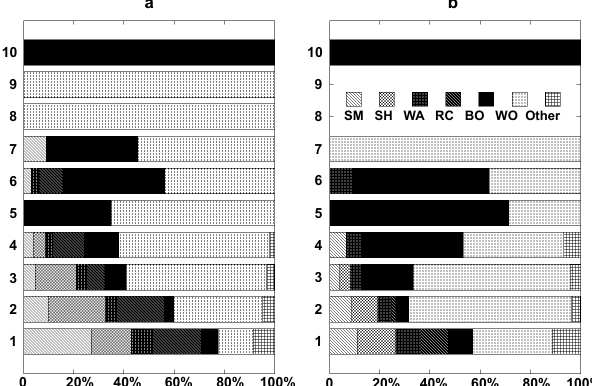
Figure 6. The relative abundance according to the 2005 forest in- ventory (a) and the total relative mortality of each species from 2005 to 2014 (b) in each diameter at breast height (DBH at 1.3m) class. The relative abundance is expressed as a percentage of stem num- ber of each species relative to the total stand stem number in each DBH class. Similarly, the relative mortality is expressed as a per- centage of total mortality of each species relative to the total stand mortality in each DBH class. Ten DBH classes with an equal width of 6.3cm are shown. The class with the smallest DBH (class 1) starts with a DBH of 9cm. This figure shows whether members of a species die proportionally or disproportionally to its abundance in the stand. SM, sugar maple; SH, shagbark hickory; WA, white ash; RC, eastern redcedar; BO, black oak; WO, white oak; Other, the other species together.